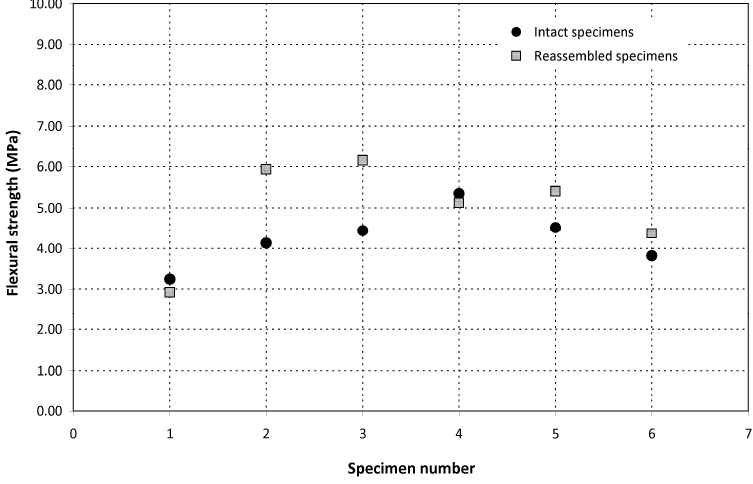
Figure 10. Flexural strength of the intact cement prisms (circles) and of the prisms obtained by re-assembling the residual fragments with sodium silicate (squares).